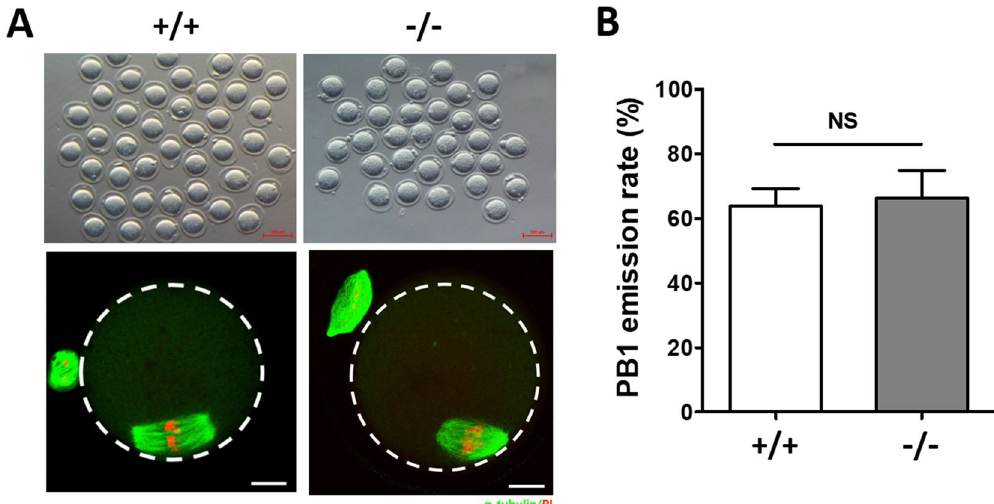
Figure 3. Oocyte maturation analysis by morphology and immunofluorescence staining. (A) Representative morphology of MII stage oocytes after superovulation at postnatal day 21 derived from Tmem150b + / + and Tmem150b -/- mice. Scale bar = 100 μm. The α-tubulin was stained by a fluorescein isothiocyanate (FITC)- conjugated antibody, and DNA by PI. Scale bar = 10 μm. (B) Statistical analysis of PB1 emission rates between Tmem150b + / + (n = 236) and Tmem150b -/- (n = 230) MII oocytes. NS, no significance.